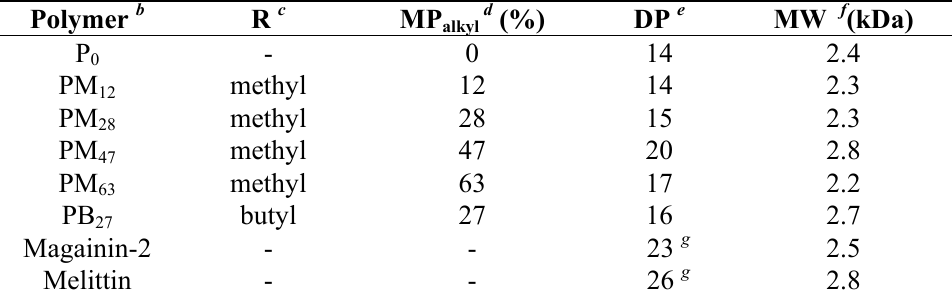
Table 1. Characterization of PMAs a and control